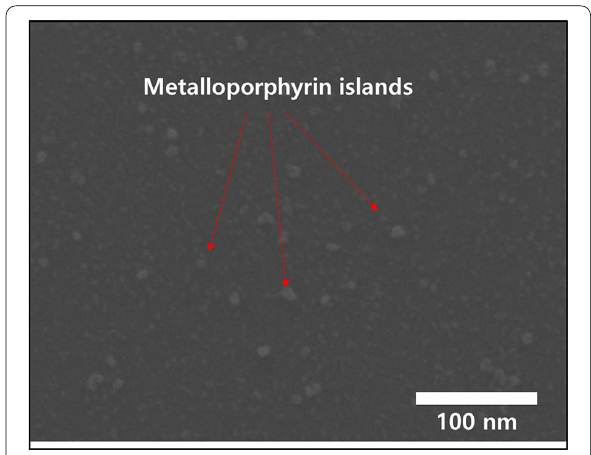
Fig. 4 A SEM image of the metalloporphyrin islands. As the amount of the deposited source was very small, a thin film could not be formed, and the source remained in the form of an island